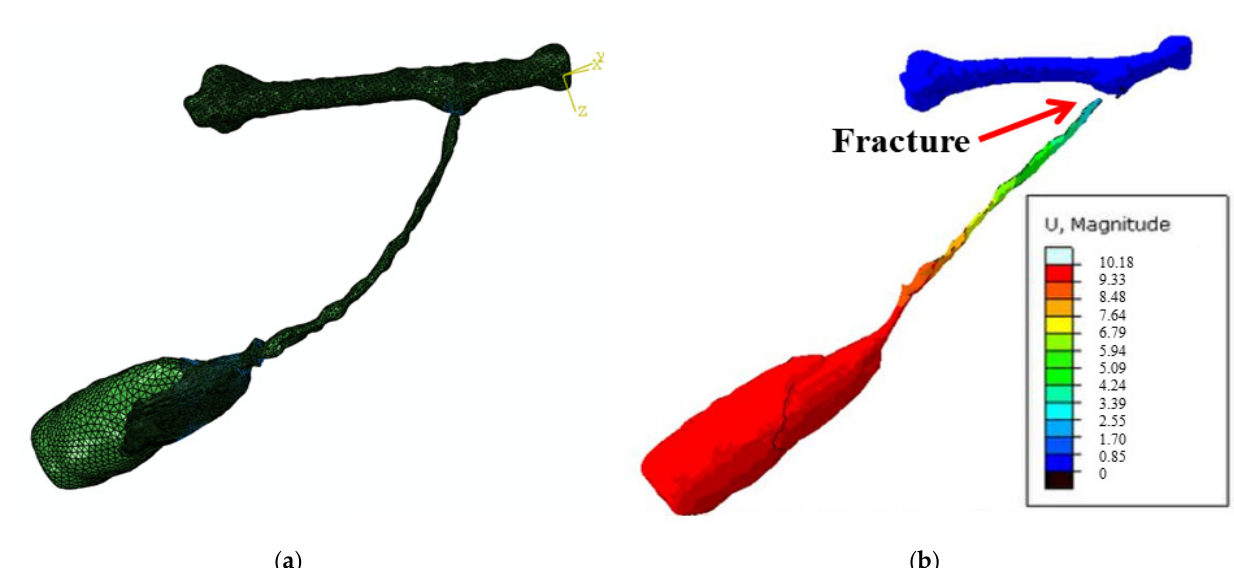
Figure 3. The meshed model ( a ) and the result ( b ) of the half-ripe fruit in the detachment simulation.